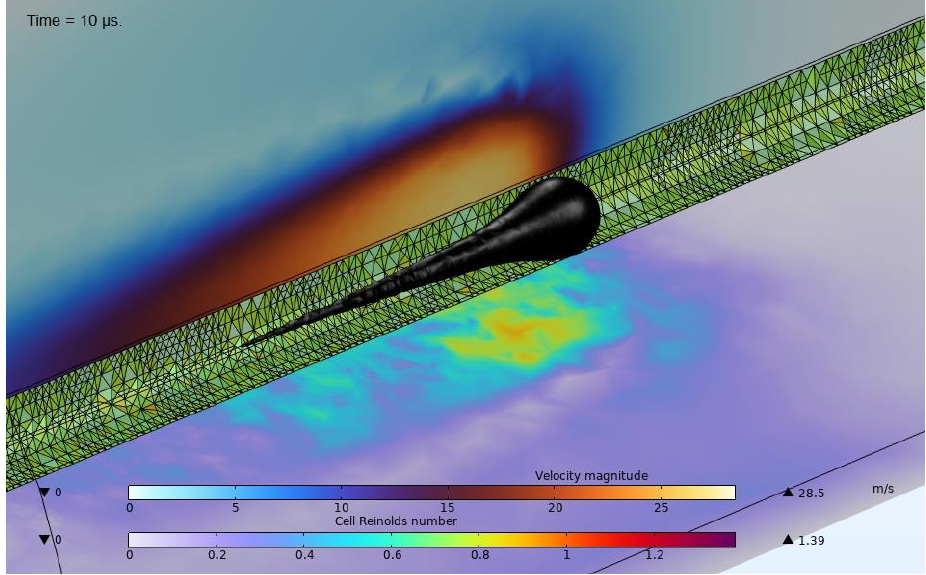
Figure 4. Illustration of the shape of a droplet in motion with a mesh and distribution of velocities.